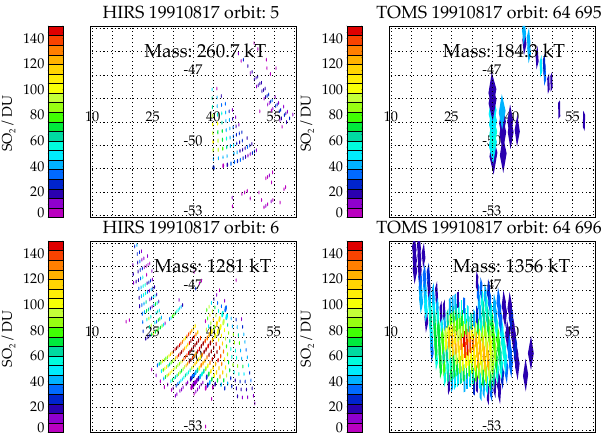
Figure 10. The main Hudson plume on 17 August 1991 as observed in orbits 5 and 6 by HIRS/2 and 64695 and 64696 by TOMS, 2 days after the main paroxysmal eruption that occurred on 15 August. Four scan lines in the HIRS/2 panels are missing due to a routine calibration phase in which no data are provided. HIRS and TOMS data are both screened at the quality level of 2 σ level (5.4. and 15DU